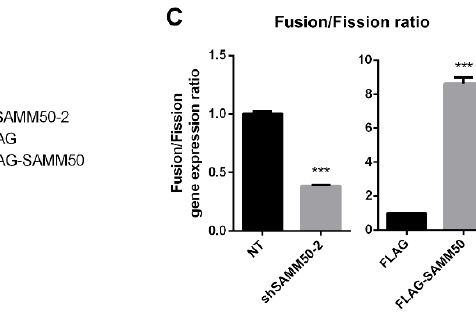
Figure 3. Knockdown and overexpression of SAMM50 in human adipose-derived stem cells. ( A , B ) qPCR and Western blot analyses were performed to determine mRNA and protein levels of SAMM50 in the shSAMM50-infected human adipose-derived stem cells using lentivirus. ( C , D ) qPCR and Western blot analyses were performed to assess mRNA and protein levels of SAMM50 in the human adipose-derived stem cells infected with FLAG-tagged SAMM50 using lentivirus. The protein levels of SAMM50 were quantified using ImageJ software. Results are shown as mean ± SEM. * p < 0.05; ** p < 0.01; *** p < 0.005 compared to the controls (NT and FLAG group, respectively).